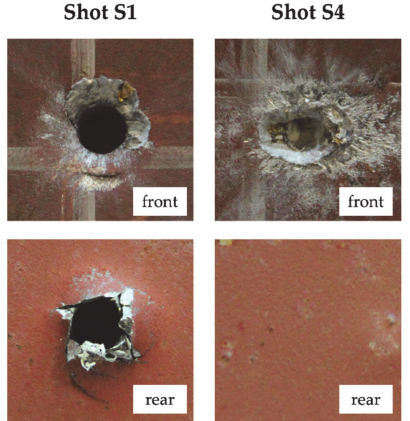
Figure 1. Damage morphology at nominal impact velocity (shot S1) and projectile arrest (shot